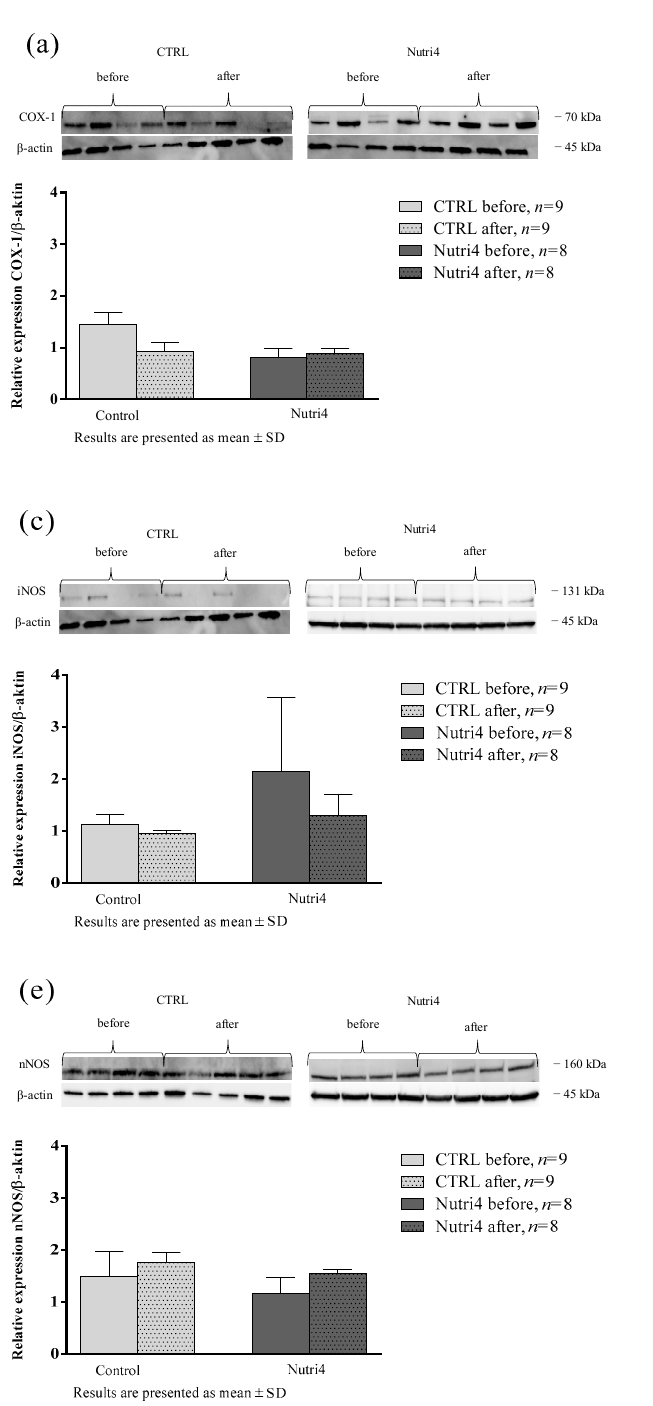
Figure 4. Relative protein expression and representative blots of ( a ) COX-1—cyclooxygenase 1; ( b ) COX-2—cyclooxygenase 2; ( c ) iNOS—inducible nitric oxide synthase; ( d ) eNOS—endothelial nitric oxide synthase; and ( e ) nNOS—neuronal nitric oxide synthase in isolated peripheral blood mononu- clear cells (PBMCs), determined by Western blot method. Results are shown as mean ± standard deviation (SD); * p < 0.05 paired t -test before and after dietary protocol (CTRL or Nutri4); # p < 0.05 One-Way ANOVA test difference between the groups.